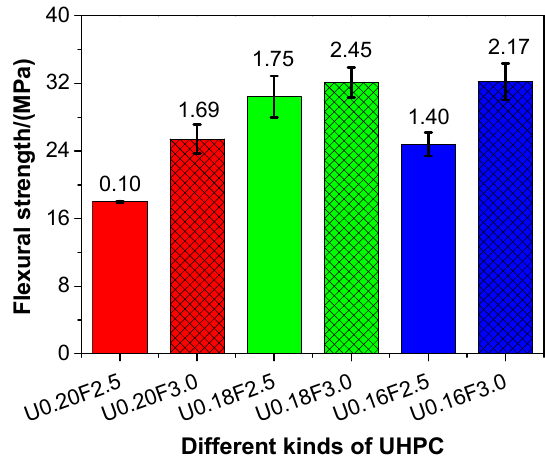
Figure 5. The flexural strength of different kinds of UHPC at 28 days.